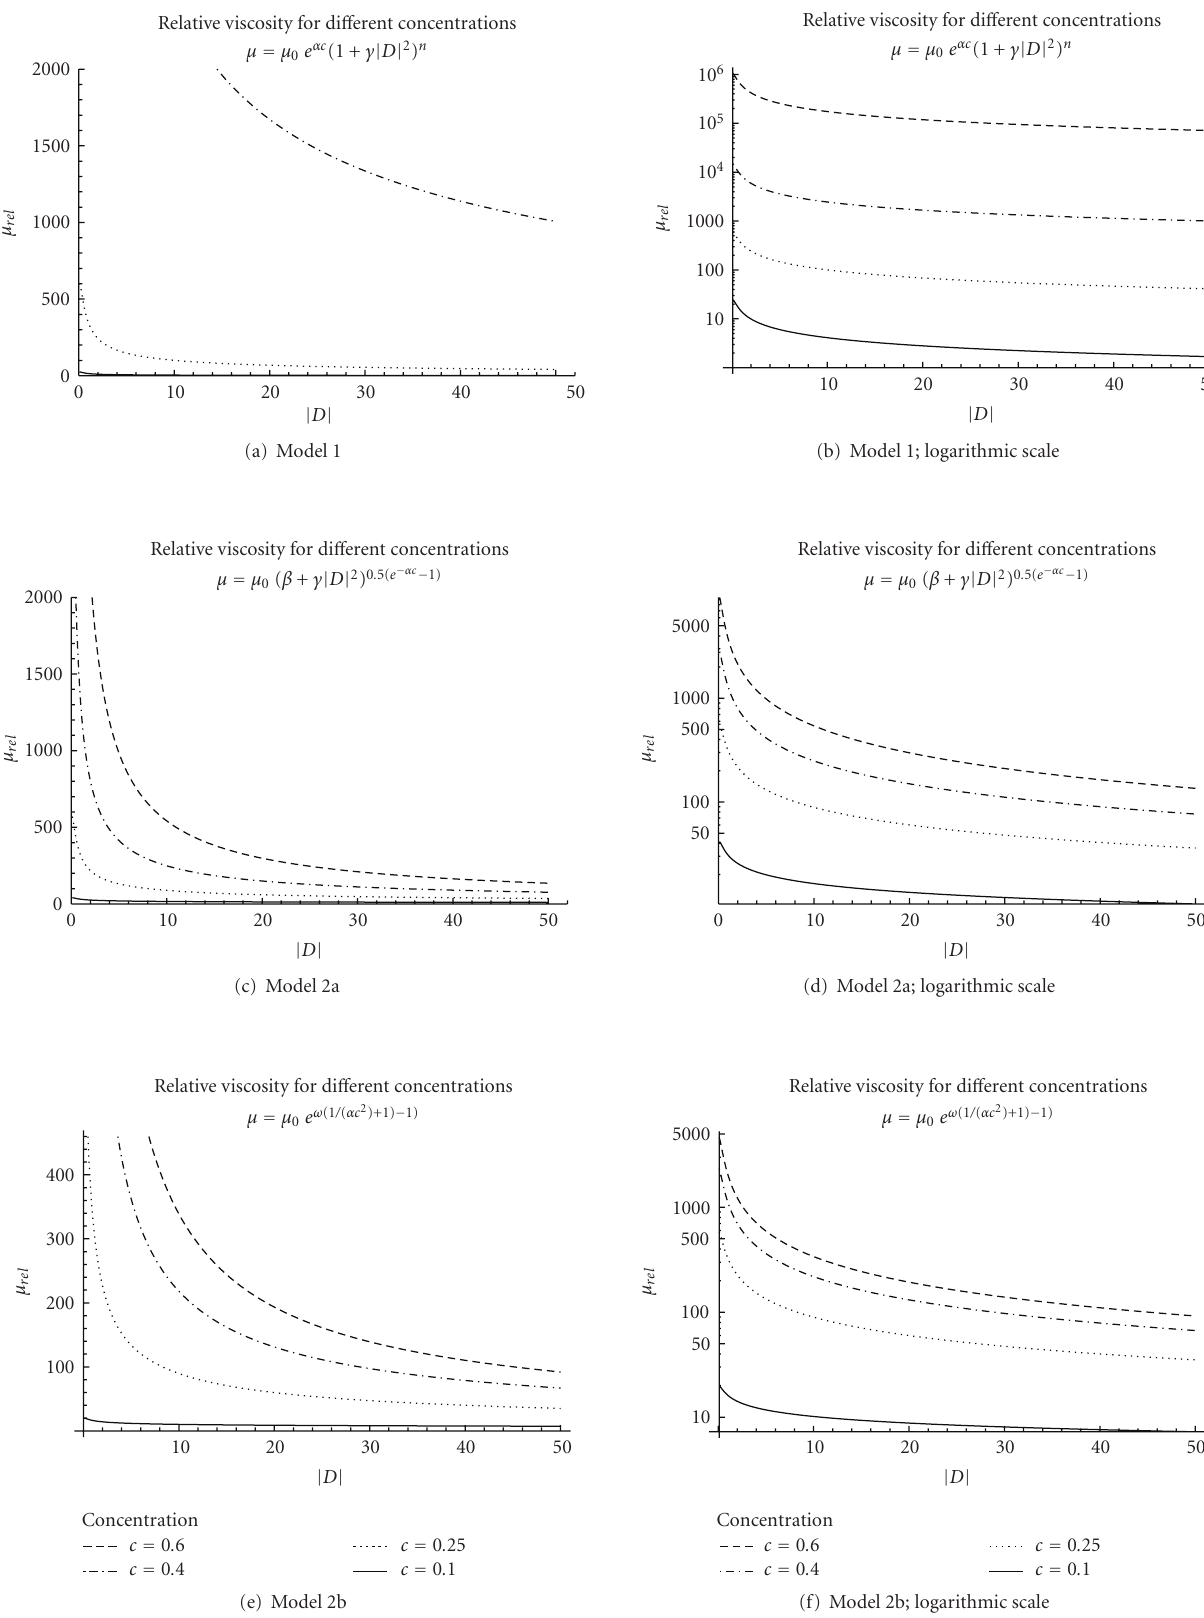
Figure 2: Relative viscosity against shear rate for higher concentrations, plots (a), (c), (e), and the same graphs in the logarithmic scale, plots (b), (d), (f). Here we use notation from Ogston and Stanier [1] for μ rel = μ/μ ref